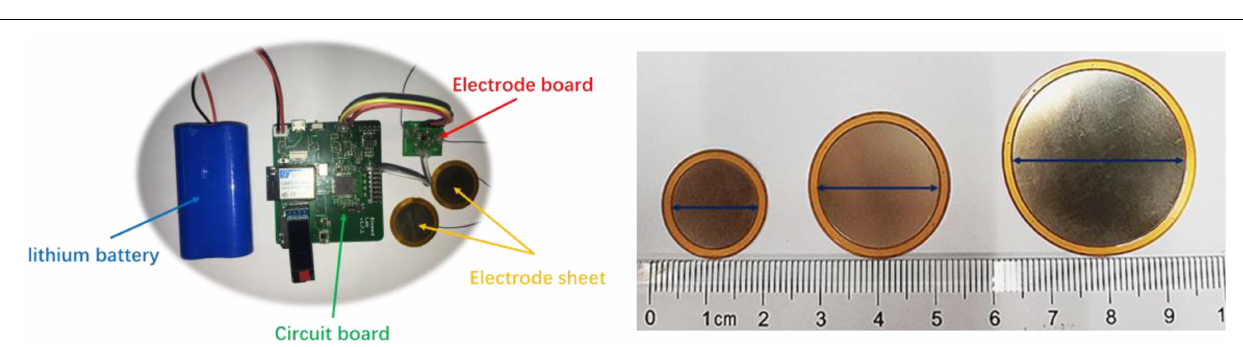
FIGURE 2 | The photos of the ECG signal acquisition system and flexible non-contact electrodes with different sizes [small (the diameter is 1.5 cm), medium (the diameter is 2.1 cm), and large (the diameter is 3.0 cm)]